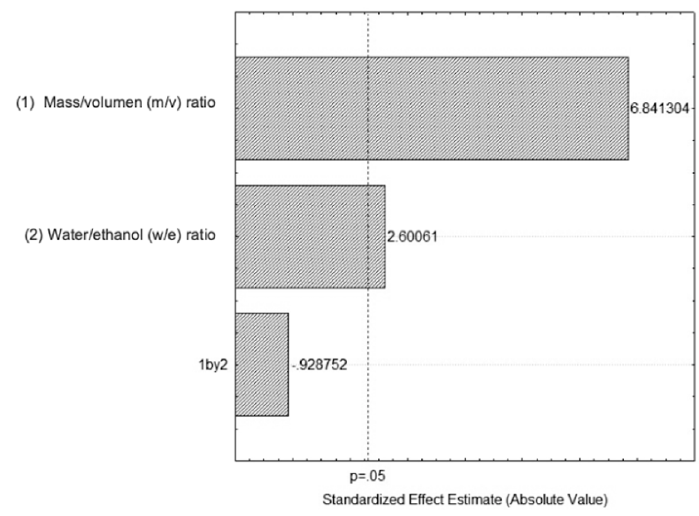
Figure 5. Standardized Pareto chart of the total polyphenol content in function of m / v ratio and e / w percentage.